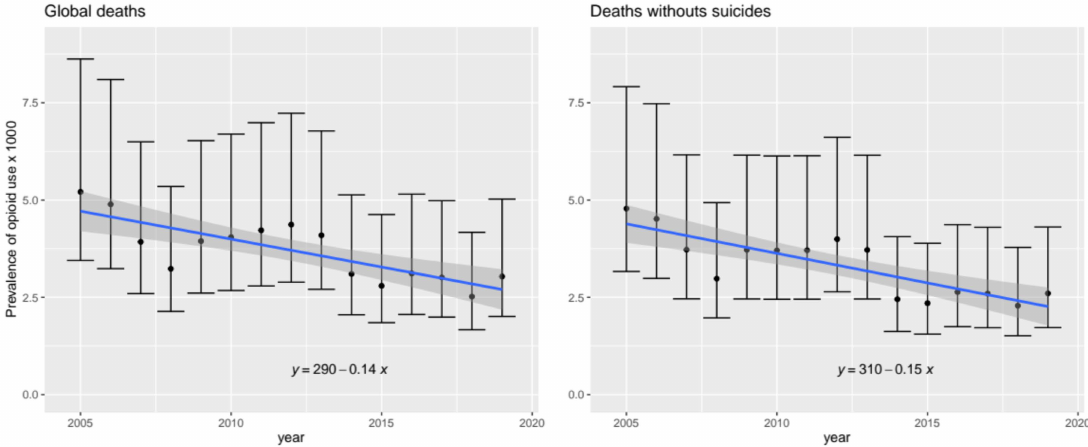
Figure 1. Estimation of recreative opioid use rate evolution in the six most populated cities of Spain